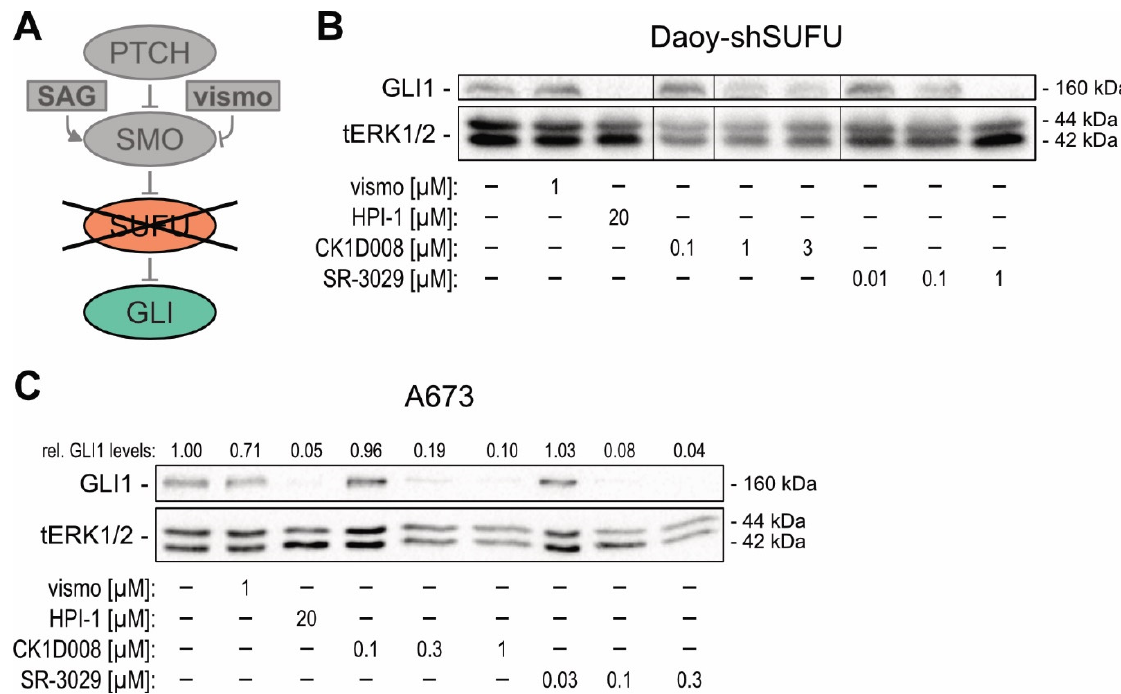
Figure 4. Pharmacological targeting of CSNK1D inhibits oncogenic HH–GLI signaling in SMOi-resistant cells. ( A ) Simplified schematic illustration of SMO-independent activation of HH–GLI signaling in Daoy medulloblastoma cells caused by the loss of the negative HH–GLI pathway regulator SUFU. ( B ) Representative Western blot analysis of GLI1 protein levels in Daoy-shSUFU cells treated with vismo [1 µM], HPI-1 [20 µM], CK1D008 [0.1–3 µM] or SR-3029 [0.01–1 µM]. ( C ) Representative Western blot analysis of GLI1 in A673 cells treated with vismo [1 µM], HPI-1 [20 µM], CK1D008 [0.1–1 µM] or SR-3029 [0.03–0.3 µM]. Relative quantification of Western blot bands was conducted via densitometric image analysis using Image Lab 5.0 software (Bio-Rad, Vienna, Austria). Relative protein levels normalized to the loading control tERK and to the Ctrl sample are shown above each protein band.